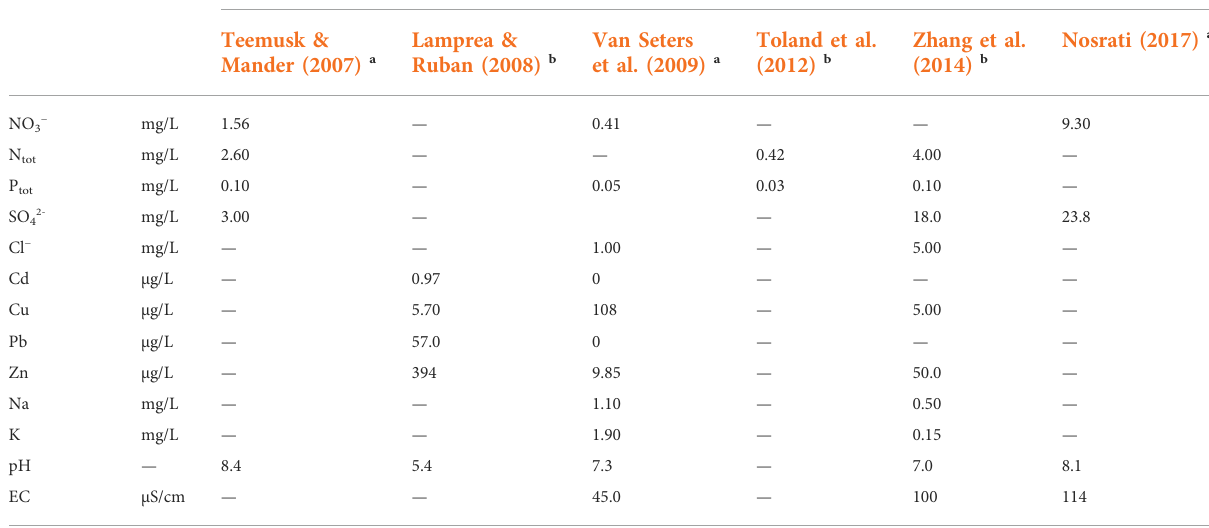
TABLE 7 Values of different parameters in bitumen roof